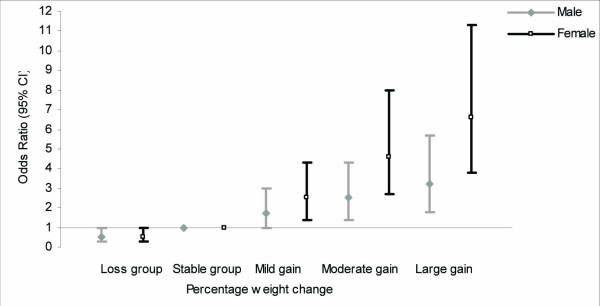
Adjusted relative risk of metabolic syndrome by weight change groups in both genders. From the total study population (1431 men and 2036 women), only 1037 men and 1180 women who were free of metabolic syndrome at baseline included in this logistic regression model. The model was adjusted for age, baseline weight, smoking, physical activity, education level and medication use. The gender-stratified percentage of weight change (PWC) was shown in the X axis, grouped as follow: weight loss group [<-1.3% men (n = 191), <-2.5% women (n = 193)]; weight stable group [-1.3 to 1.3% men (n = 185), -2.5 to 1.2% women (n = 204)]; mild weight gain group [1.4 to 3.9% men (n = 209), 1.3 to 3.9% women (n = 228)]; moderate weight gain group [4 to 6.9% men (n = 204), 4 to 7.6% women (n = 233)]; large weight gain group [= 7% men (n = 248), = 7.7% women (n = 322)]. The stable group was considered as reference. Relative risk (95% CI) for ATPIII defined metabolic syndrome according to PWC groups was shown in the Y axis.